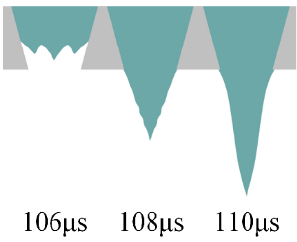
Figure 8. Ink is squeezed out of the chamber to form a ligament when the t f is 1 µs.